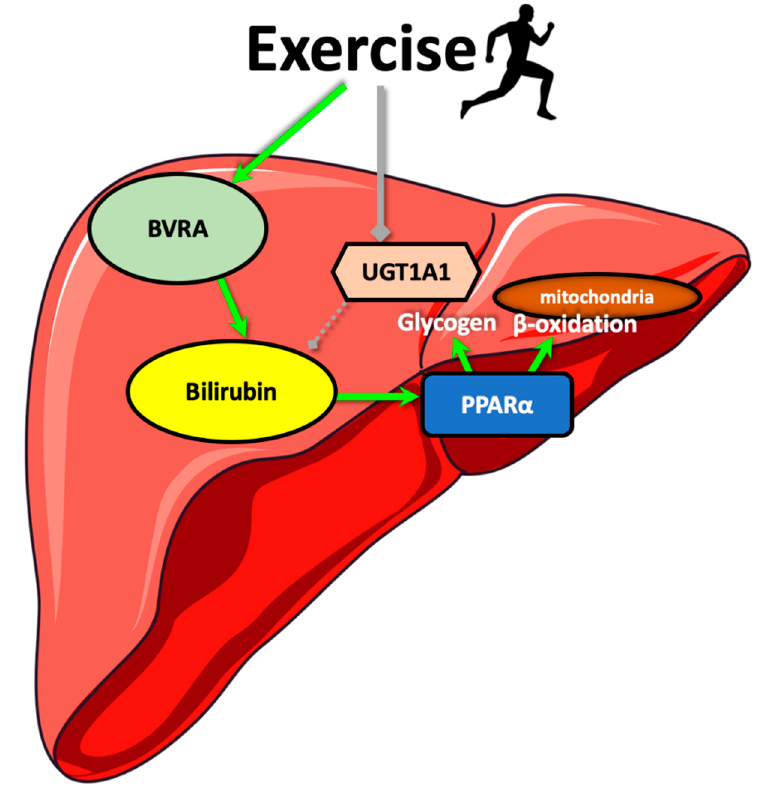
Figure 7. Schematic diagram of the proposed pathway by which exercise regulates plasma bilirubin levels. Exercise upregulates hepatic biliverdin reductase-A (BVRA) and suppresses UDP Glucuronosyltransferase Family 1 Member A1 (UGT1A1) resulting in increased plasma levels of bilirubin. Bilirubin then activates hepatic peroxisome proliferator-activated receptor- α (PPAR α ) and its target genes to enhance glycogen synthesis and mitochondrial β -oxidation.